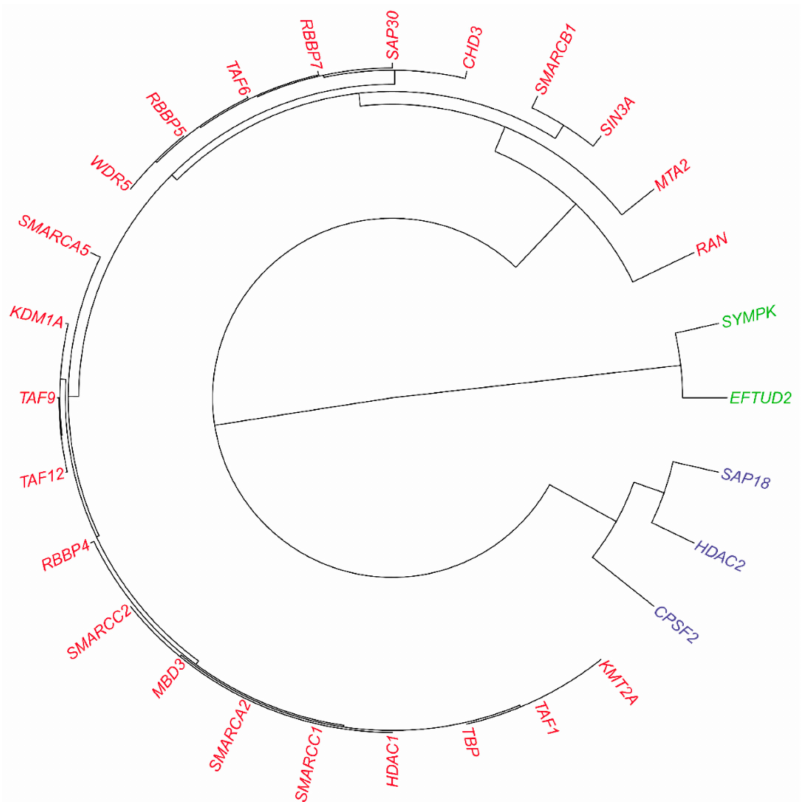
Figure 6. Predicted physical interactions via supervised learning and inferred hierarchical sub- complexes via GO semantic similarity based functional clustering within ALL-1 supercomplex from CORUM [4] (28